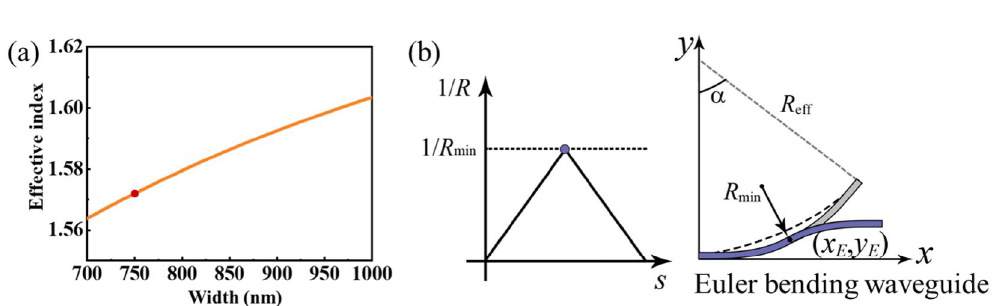
Figure 4. ( a ) Effective index of the TM mode as a function of width of the input waveguide w s , the phase-match point marked with a red dot. ( b ) The basic concept of the Euler bending waveguide used in the